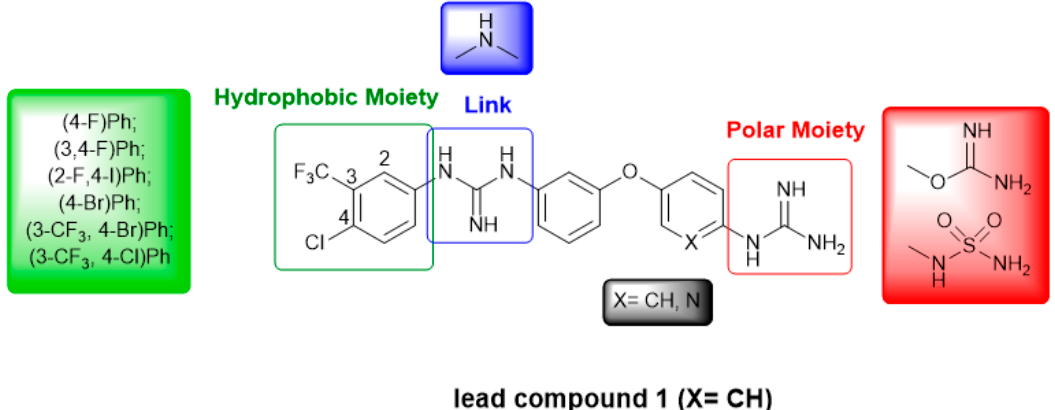
Figure 1. Structural modifications proposed for the optimization of the compound 1 .